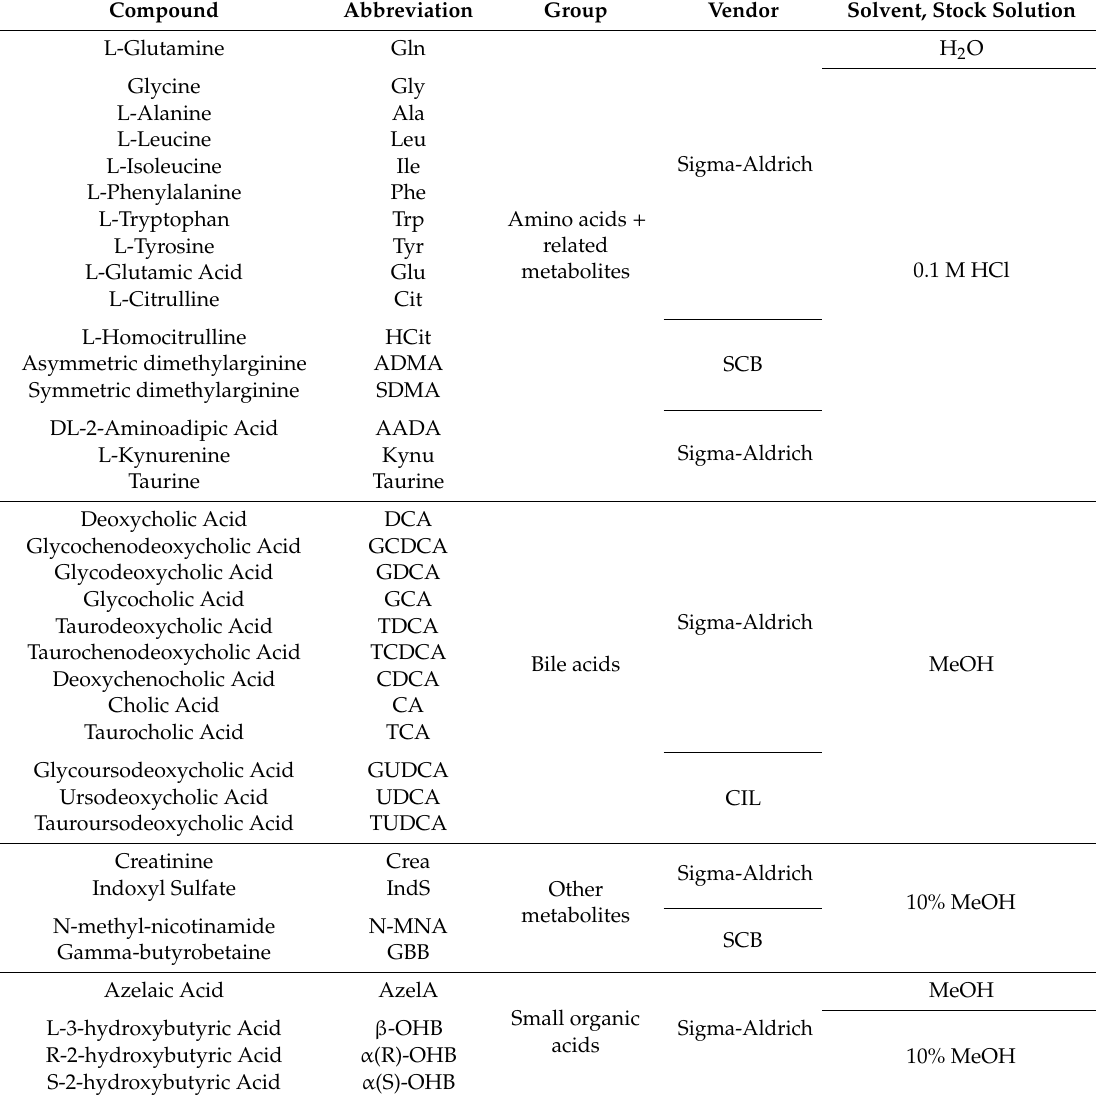
Table 1. Standard compounds acquired for quality control and for